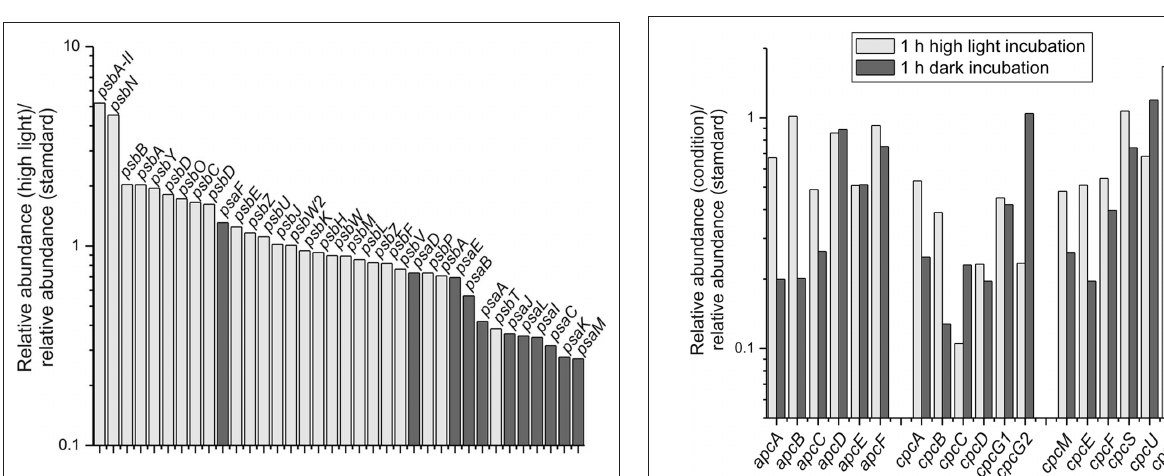
Figure 4 | relative transcript levels of genes encoding components of photosystem i and photosystem ii after a 1-h exposure to high light compared to standard conditions. The transcript level of genes encoding components of PS II (light gray) and PS I genes (dark gray) are displayed as the ratio of the relative transcript abundances for high-light-treated cells compared to the mean of three samples for standard conditions. A value of 1 represents an equal mRNA level under both conditions; values greater than 1 indicate an increase in relative transcript abundance; and values lower than 1 represent a decrease in relative transcript abundance after a 1-h exposure to high light.